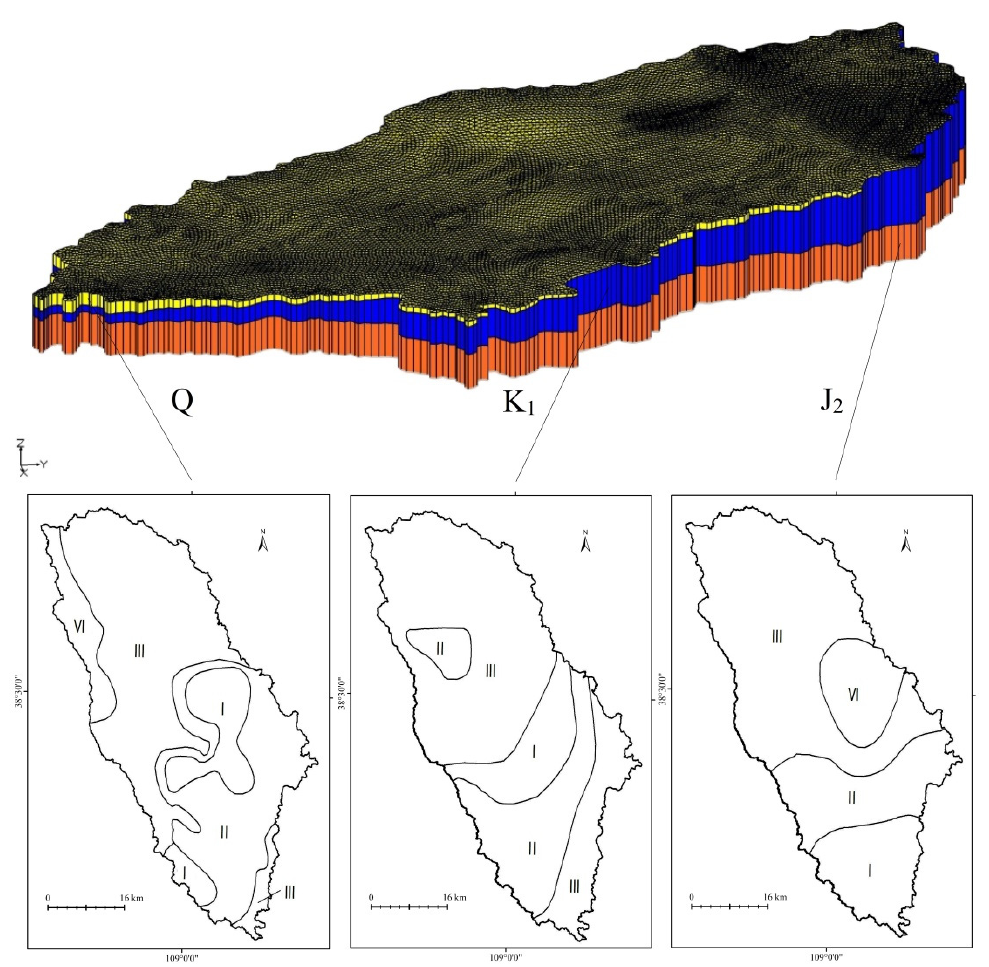
Figure 5. Three-dimensional hydrogeological solid model and hydrogeological parameter parti- tioning.